Question: What visual encoding does this figure use to show its data?
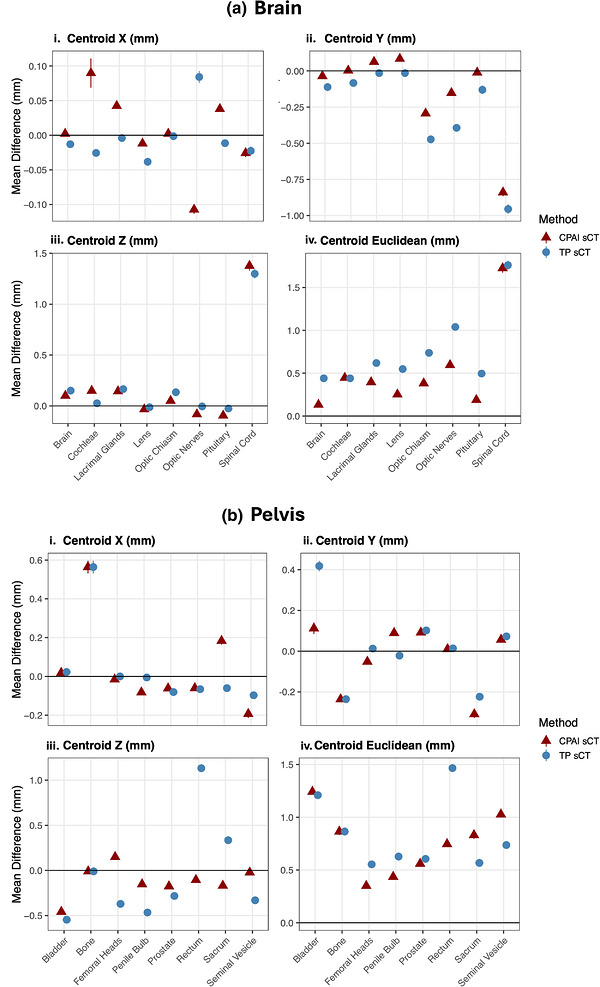
Answer: bar